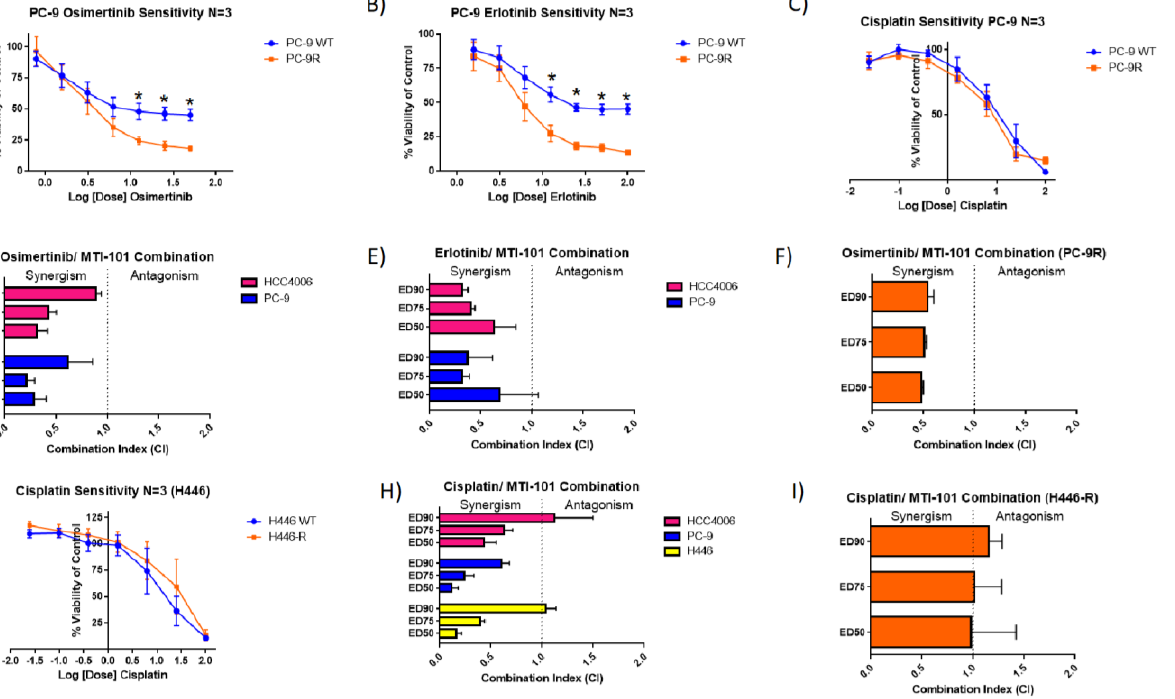
Figure 6. Selection for resistance to MTI-101 demonstrates collateral sensitivity to EGFR inhibitors but not Cis-Platinum treatment. Seventy-two-hour MTT assays were performed with the single treatment of osimertinib, erlotinib or cisplatin comparing WT to their respective MTI-101-resistant cell line. IC 50 values comparing PC-9 to PC-9R were significant with osimertinib and erlotinib (significance p < 0.05, T -test) ( A – C , G ). Seventy-two-hour MTTs using combination therapy with MTI-101 in PC-9, HCC4006 and PC-9R demonstrate synergism with EGFR inhibitors ( D – F ). Forty-eight-hour MTTs using combination therapy with MTI-101 and cisplatin were synergistic in HCC4006, PC-9 and H446 cells ( H ) and additive in H446-R ( I ). Drug combination effects were determined by using CompuSyn software analysis. Shown is the mean CI of n = 3 independent experiments. Error bars represent SEM (significances denoted * for p < 0.05, two-tailed t